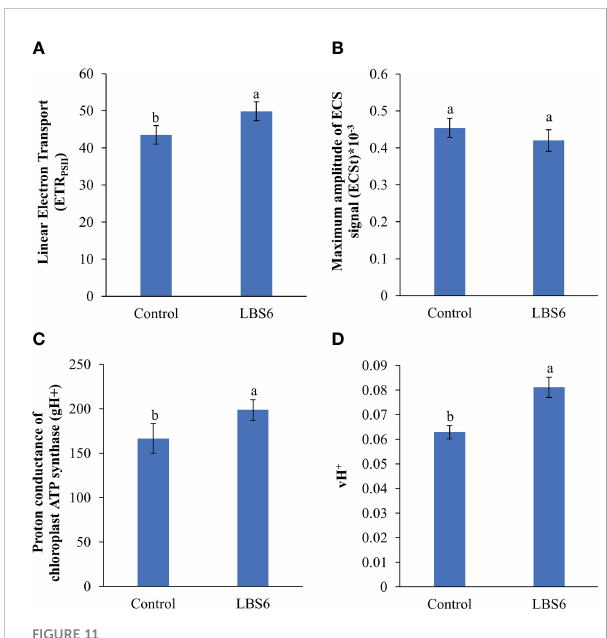
FIGURE 11 Effect of LBS6 on (A) linear electron transport, (B) maximum amplitude of ECS signal (ECS t ), (C) proton conductance of chloroplast ATP synthase (gH + ), and (D) estimated proton fl ux through thylakoid lumen (vH + ). The values were presented as mean ± SE and means represented by the same letters were not signi fi cantly different at p ≤ 0.01. Each experiment was carried out in triplicate, and each experimental unit had ten plants (n =